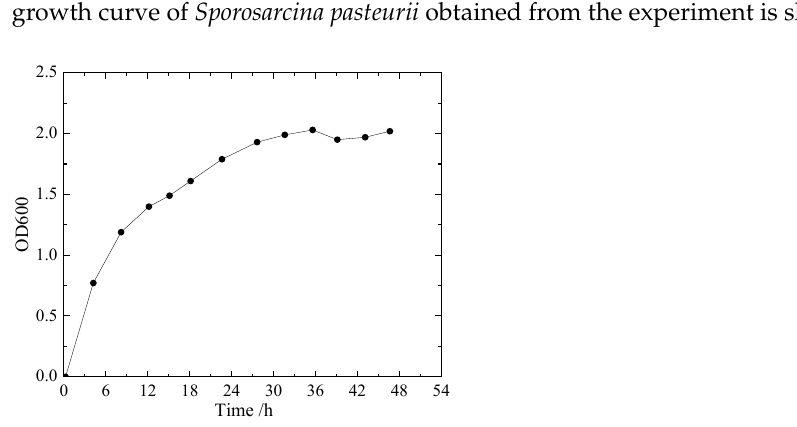
Figure 1. Growth curve of Sporosarcina pasteurii.